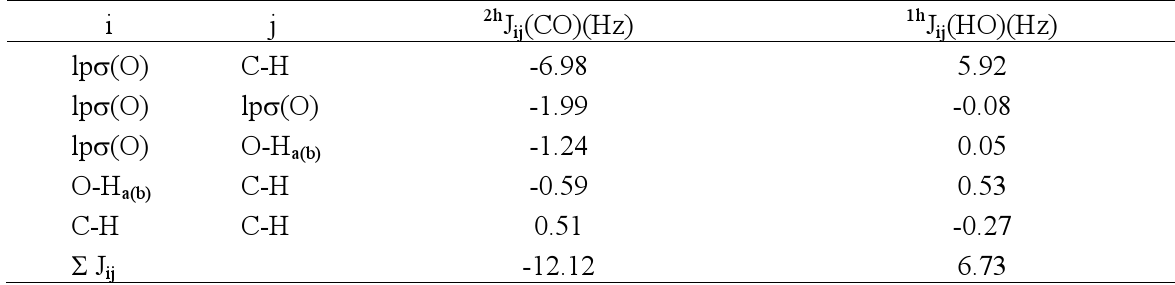
Table 2. Main J coupling pathways (i,j, occupied LMOs) for 2h J(CO) and 1h J(HO) in system ij